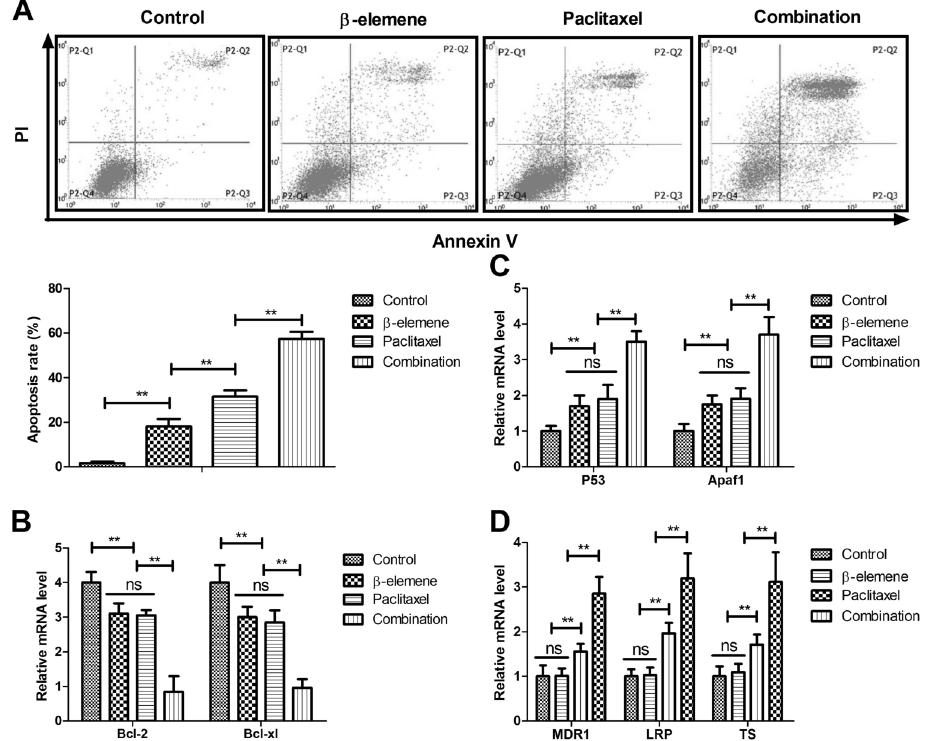
Figure 3. Effect of b -elemene (100 mg/mL), paclitaxel (20 mg/mL), or their combination on apoptosis of SKOV3 cells ( A ), and the relative mRNA expression of Bcl-2 and Bcl-xl ( B ), P53 and Apaf1 ( C ), and MDR1, LRP, and TS ( D ). Data are reported as means ± SD. **P o 0.01 (ANOVA followed by Tukey ’ s multiple comparison post hoc test). ns: not signi fi b -elemene + paclitaxel suppressed growth and cell optimal inhibition effect on SKOV3 cells growth. Results cycle of SKOV3 cells showed that 20 mg/mL of paclitaxel presented the As illustrated in Figure 2A, b -elemene + paclitaxel maximum inhibitory effect on SKOV3 cells growth inhibited growth of SKOV3 cells compared to either (Figure 1B).